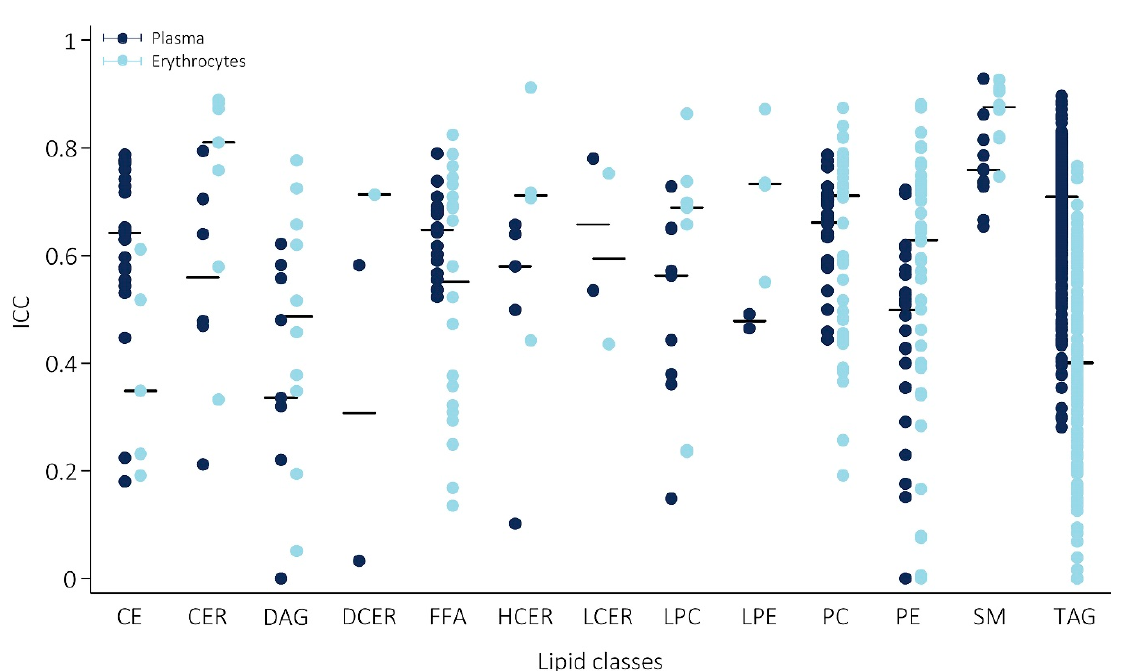
Figure 3. Reproducibility of the lipids over a 6 ‐ week period, stratified by lipid class. Reproducibility of individual lipids within each class in plasma (blue) and erythrocytes (red); bars represent the median intraclass correlation coefficient (ICC) of the lipid class. Abbreviations: ICC = intraclass correlation coefficient, CE = cholesteryl ester, CER = ceramide, DAG = diacylglycerol, DCER = dihydroceramide, FFA = free fatty acid, HCER = hexosylceramide, LCER = lactosylceramide, (L)PC = (lyso)phosphatidylcholines, (L)PE = (lyso)phosphatidylethanolamine, SM = sphingomyelin, TAG = triacylglycerol.